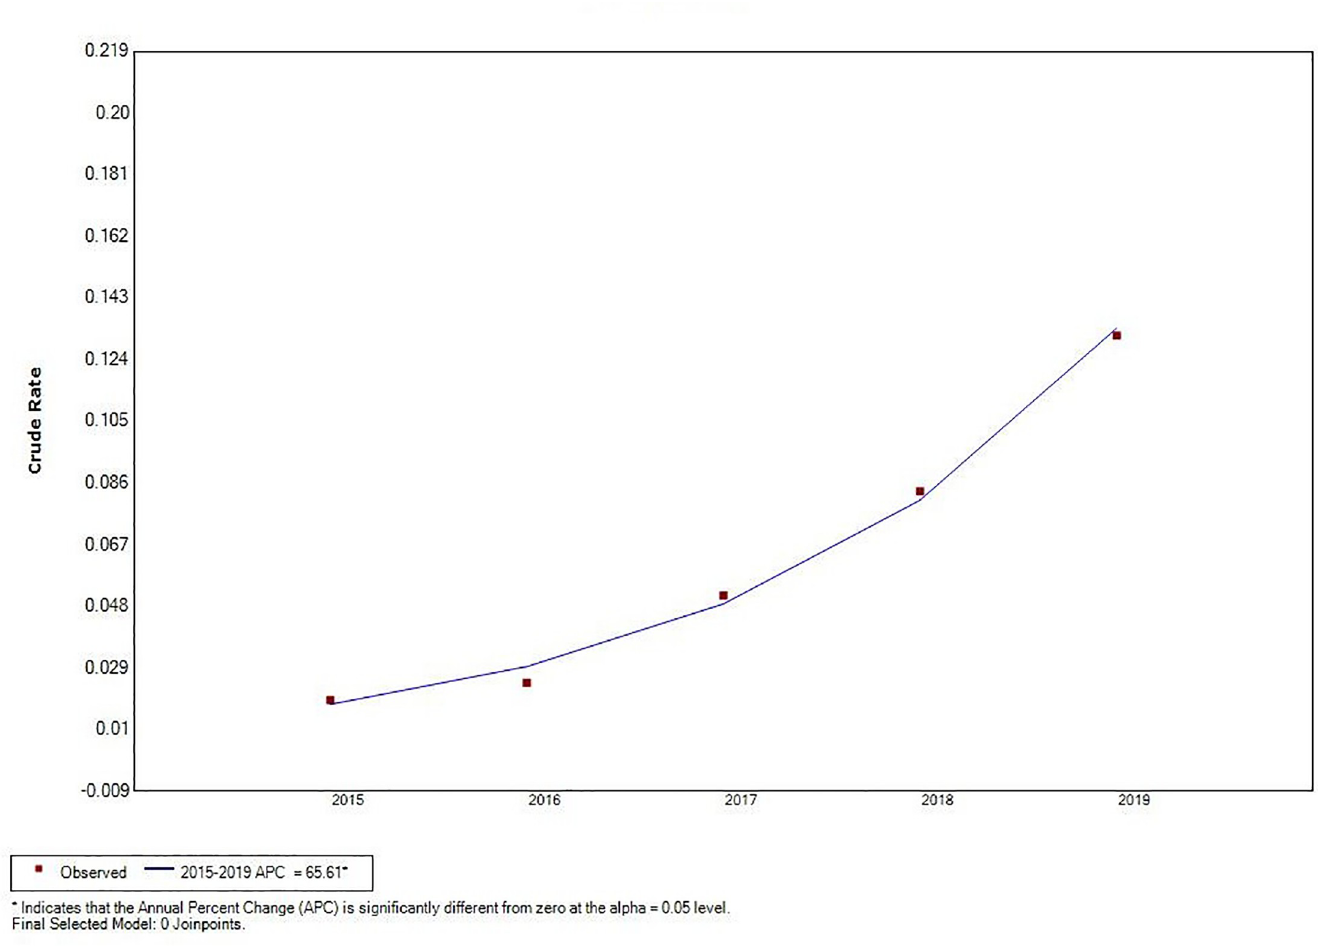
Fig 5. The joinpoint regression analysis for determining changes in the trend of mountain-type zoonotic visceral leishmaniasis incidence in Shanxi province from 2015 to 2019.